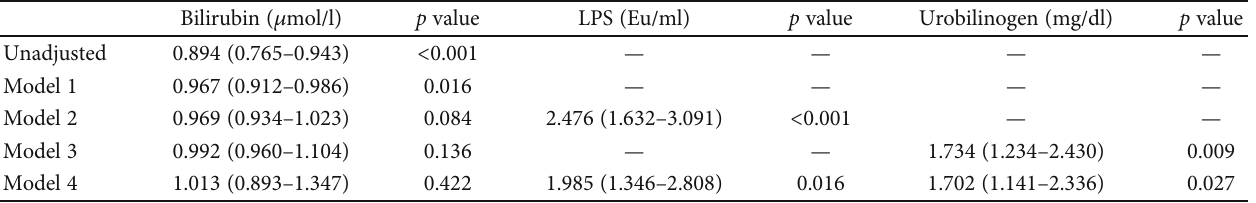
Table 3: Odds ratios for severe DR.